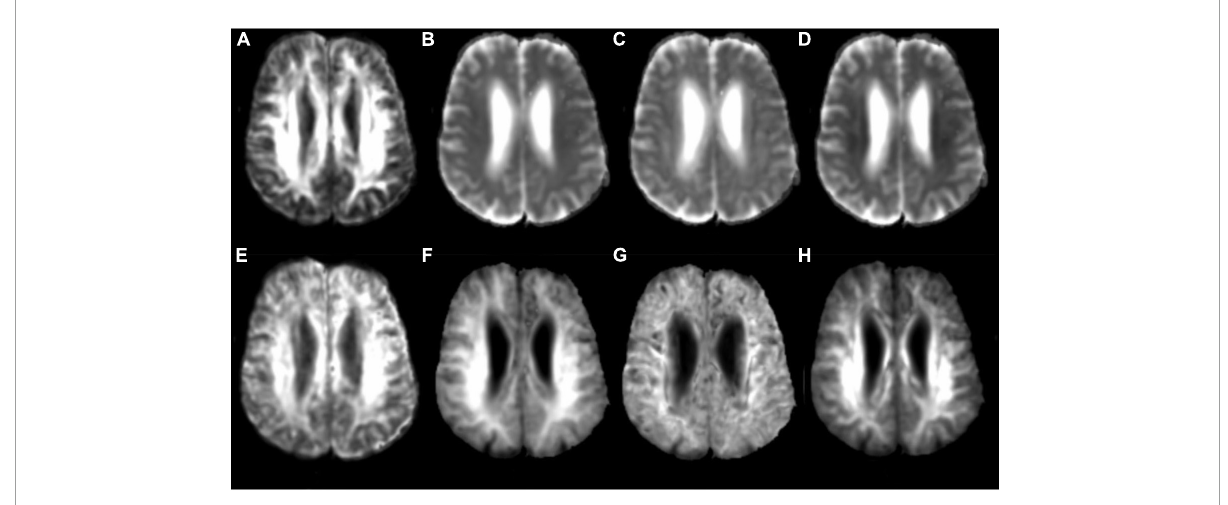
FIGURE1 Diffusion kurtosis imaging (DKI) parameter image. (A) FA: fractional anisotropy; (B) MD: mean diffusion; (C) Da: axial diffusion; (D) Dr: radial diffusion; (E) FAK: fractional anisotropy of kurtosis; (F) MK: mean kurtosis; (G) Ka: axial kurtosis; (H) Kr: radial